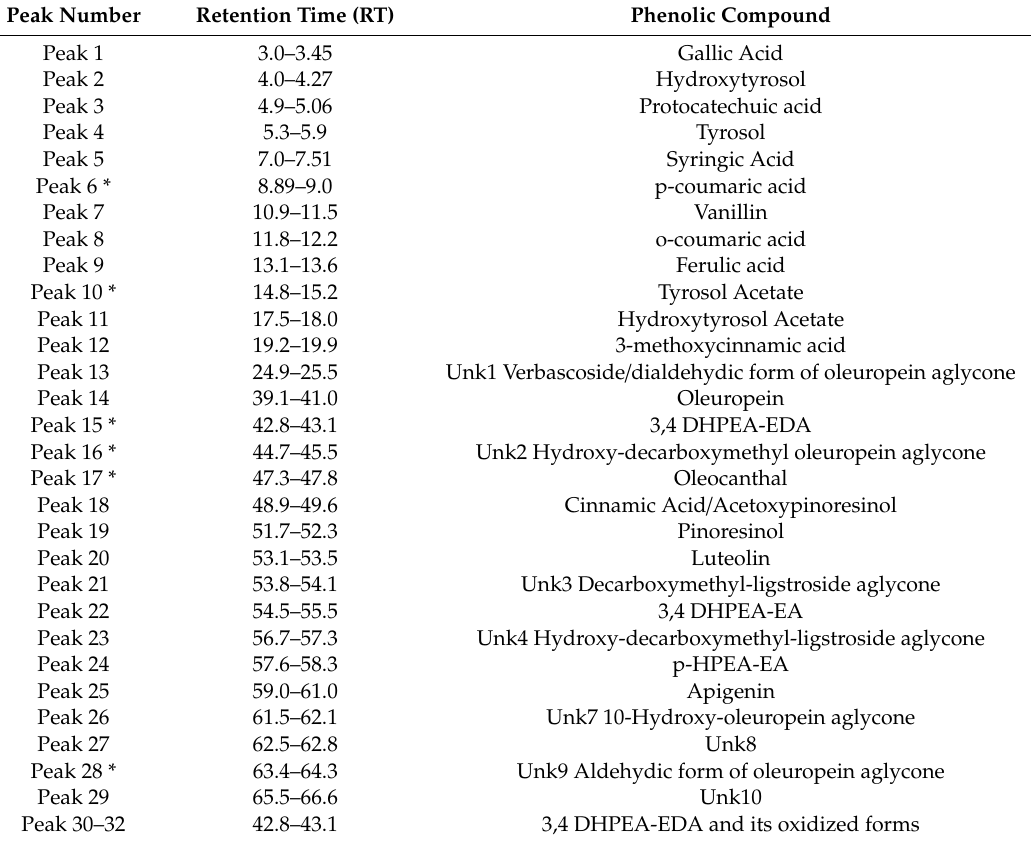
Table 1. Peak number, retention times and phenolic compounds at 280